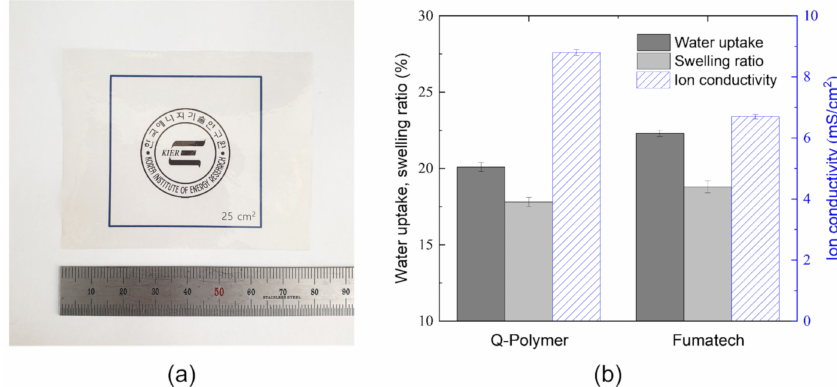
Figure 9. ( a ) Photograph of the Q-Polymer membrane (Cl − form) and ( b ) comparison of the water uptake, swelling ratio, and ion conductivity of Q-Polymer and Fumatech (FAA-3-50) membranes measured in deionized water (DIW) at 25 ◦ C.